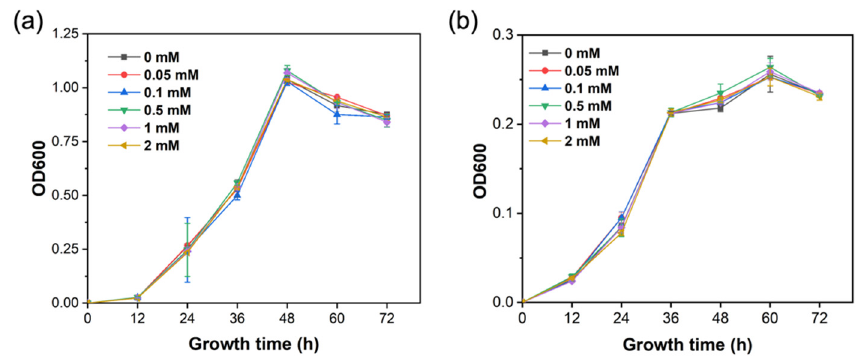
Figure 2. Effects of different Si concentrations on the growth curve of R. solanacearum . ( a ) The growth curve of R. solanacearum in liquid LB medium. ( b ) The growth curve of R. solanacearum in liquid MM medium.